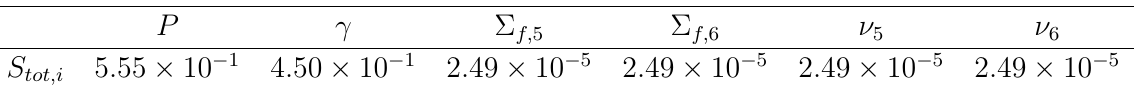
Figure 2: (a) Pdf representation of T using different polynomials orders and number of max samples compared with the reference MC sampling. (b) Normal probability plot on the 3 rd order polynomial curve. Blue crosses are the related to the sampling whereas the dashed line is the reference Gaussian. The tails show clearly non-Gaussian behavior. Table 3: Total sensitivity indices for T . The power and the HTC give the only relevant max contribution to the response variance.